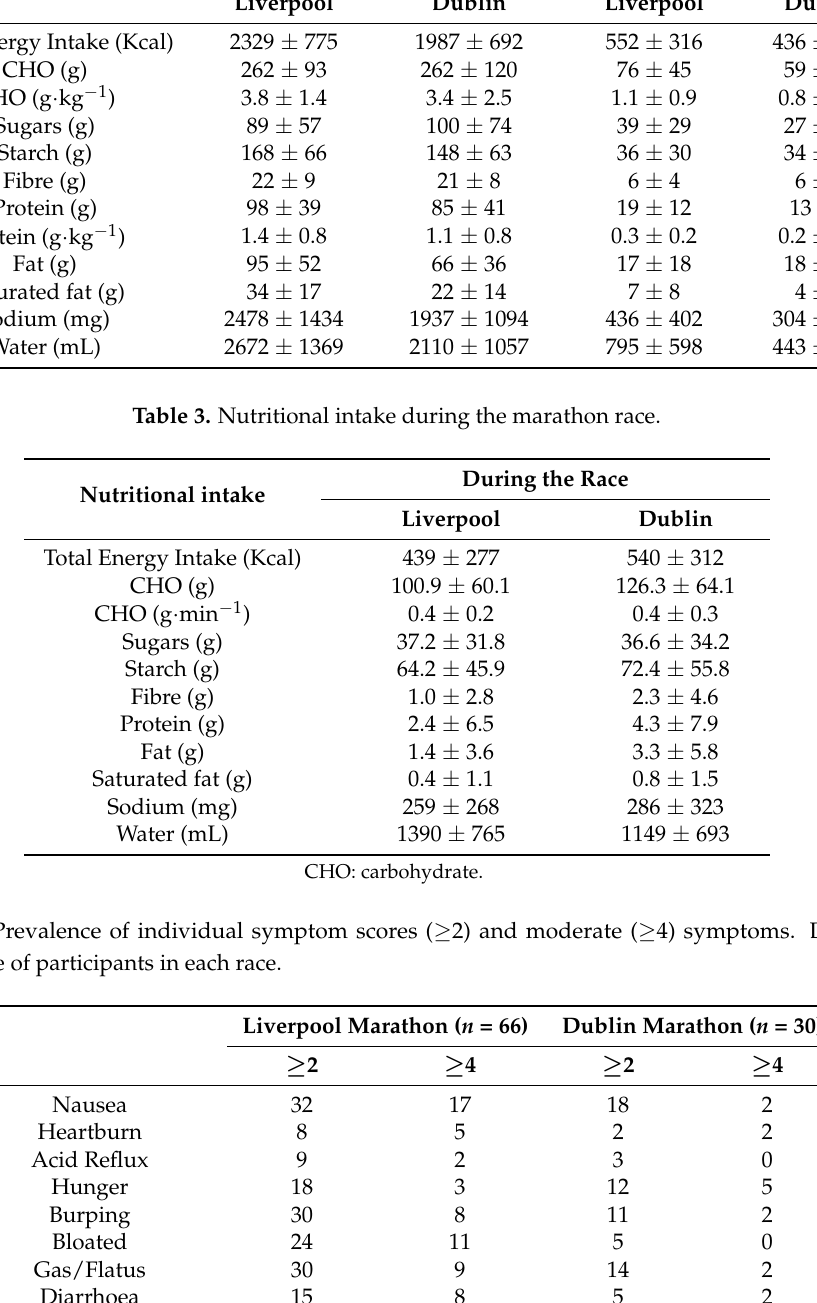
Table 2. Nutritional intake on the day before the race and during the race-day breakfast. Nutritional intake